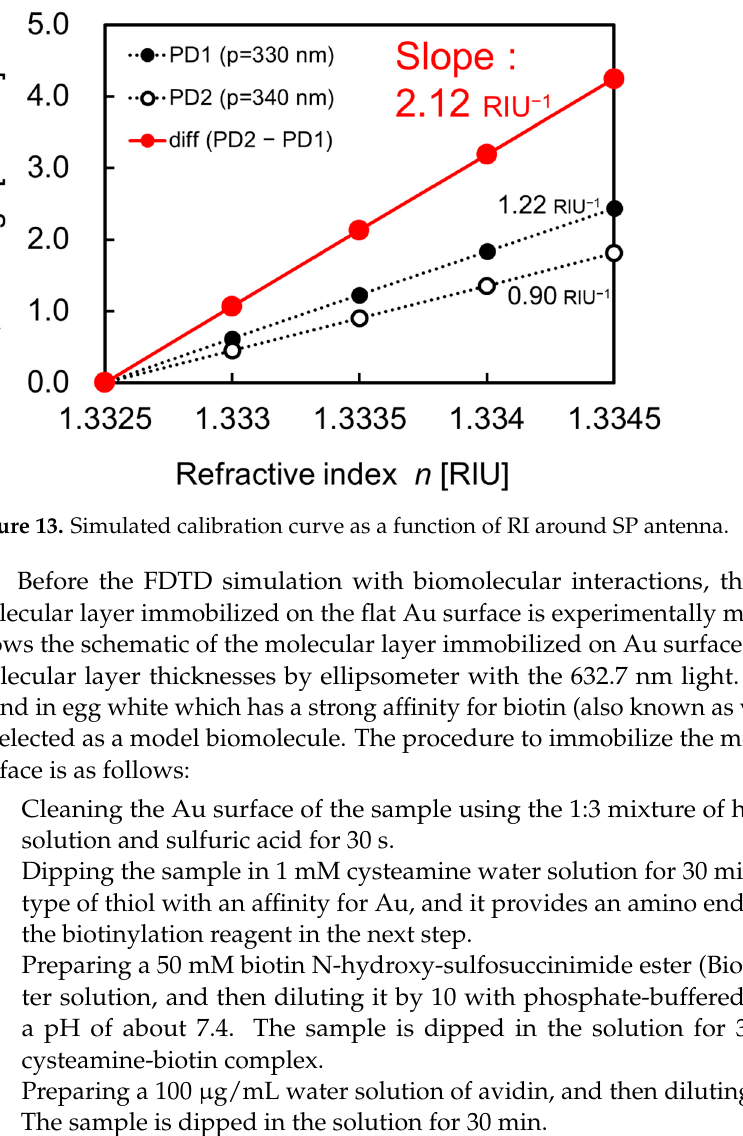
Figure 12. Simulated and measured quantum efficiencies (QEs) with respect to incident angle to device surface.